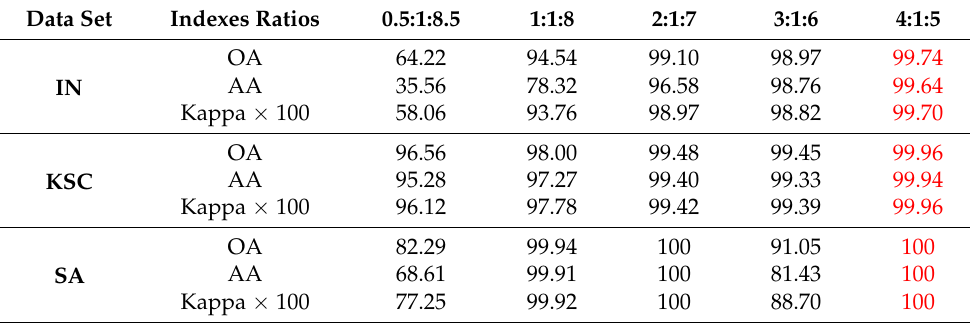
Table 5. The influence of different sample ratios on three HSI datasets.